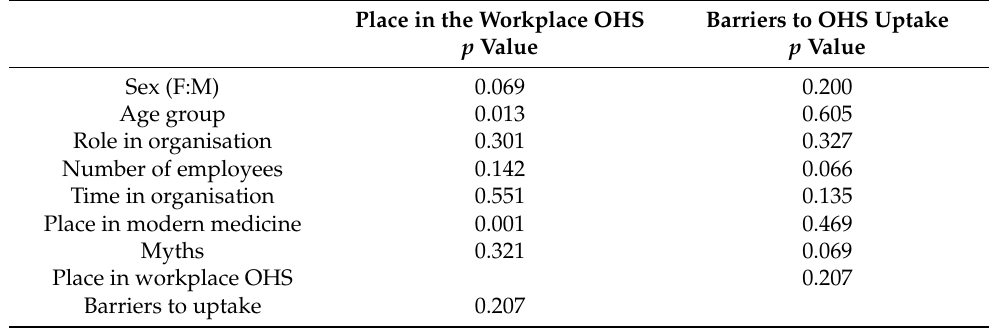
Table 2. Associations between AIHS participant profile and perceptions and barriers to OHS hypnotherapy.